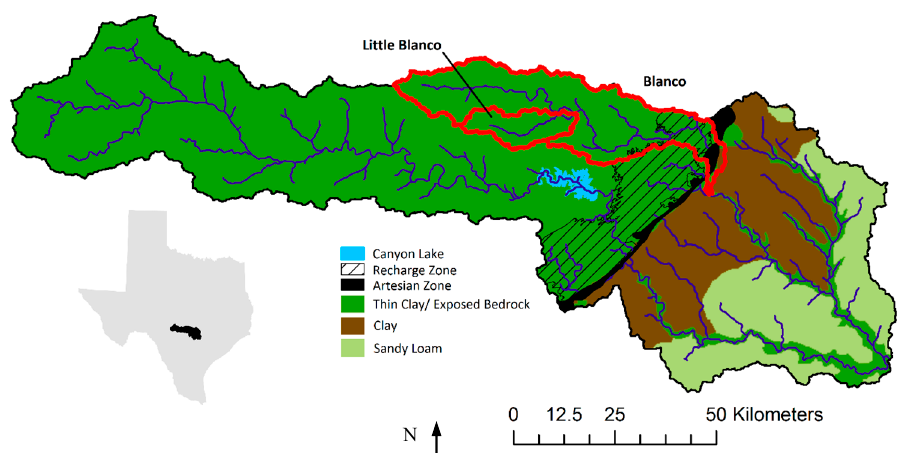
Figure 1. Location and area map of the study watersheds along with a generalized soil map. Each of the three interior watersheds are outlined, and the Edwards Aquifer recharge and artesian zones are displayed.